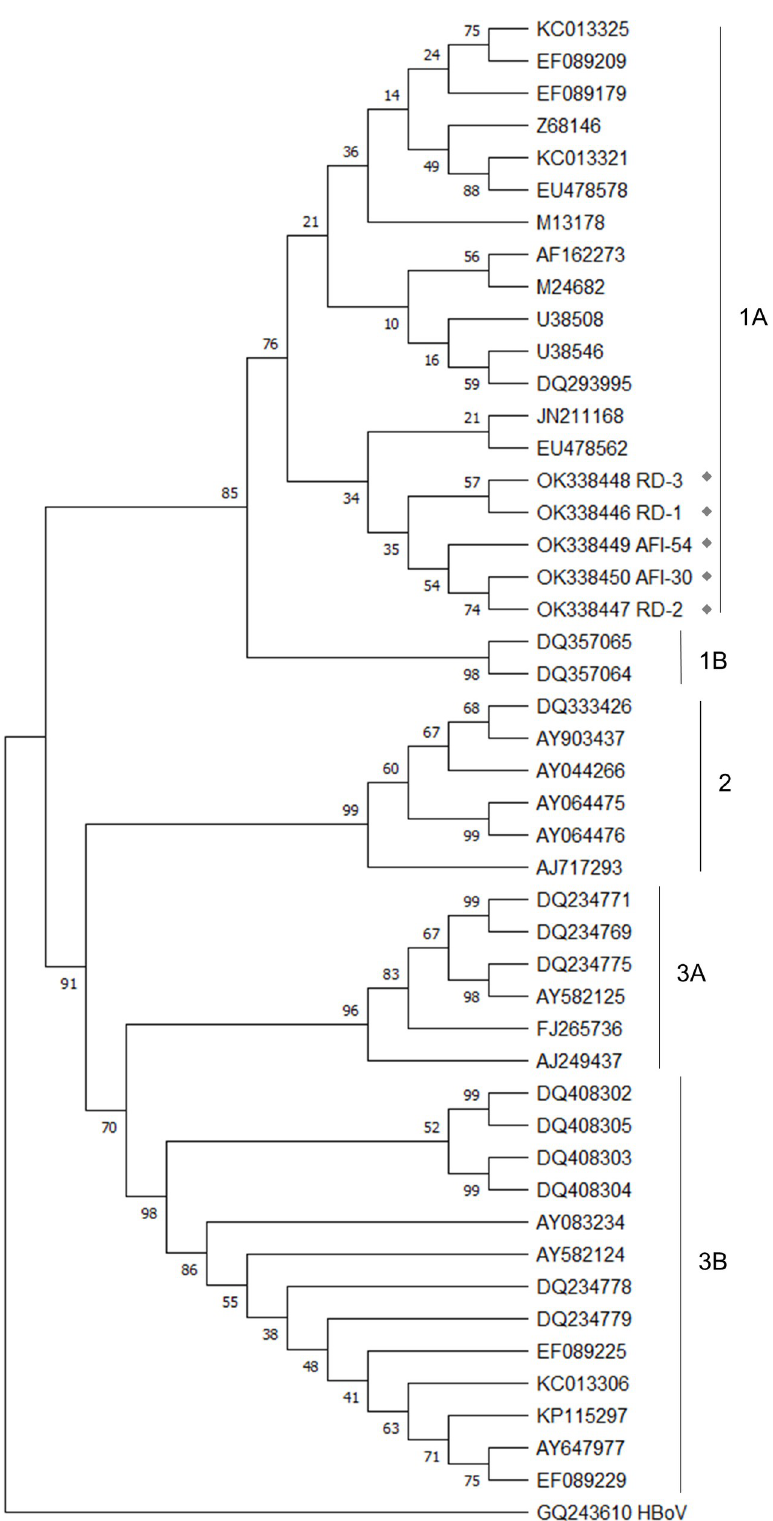
Fig 1. Evolutionary history of B19V genotypes, detected in patients with RD and AFI from Rio de Janeiro, Brazil between 2018 and 2019, inferred by using the Maximum Likelihood method and Tamura-Nei+G+I model.